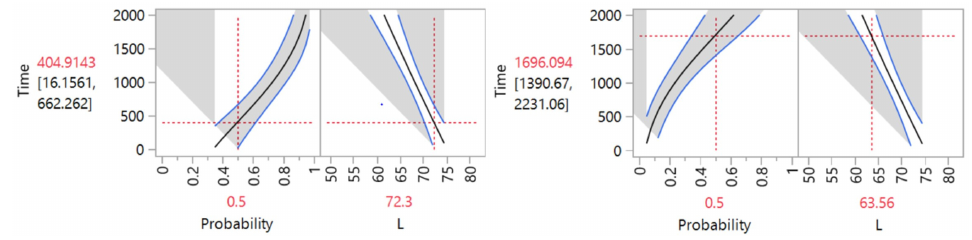
Figure 6. Intersection point in time: ( left ) 10% ( right ) 20% degradation.